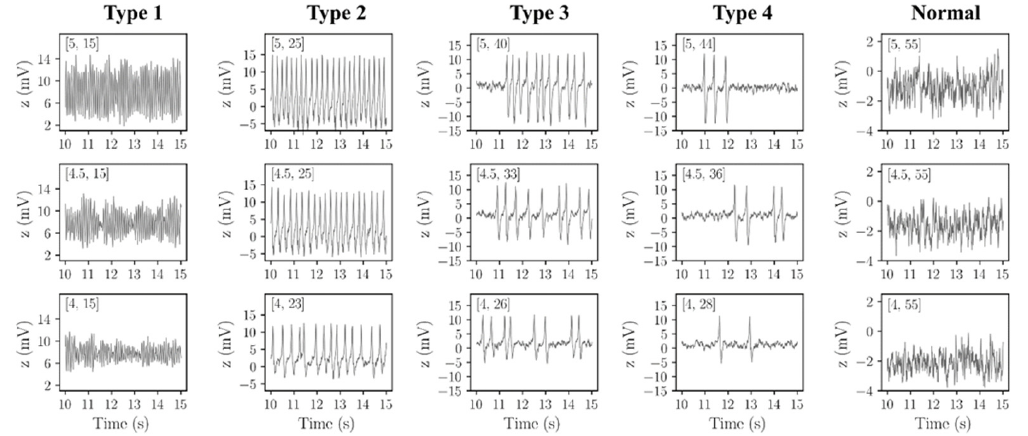
Figure A2. z(t) segments produced by changing the values of A and B (in the square brackets) in the mathematical model to represent normal and four types of epileptiform discharges. Each combination of parameters was used to produces 50 EEG segments of 5 s.